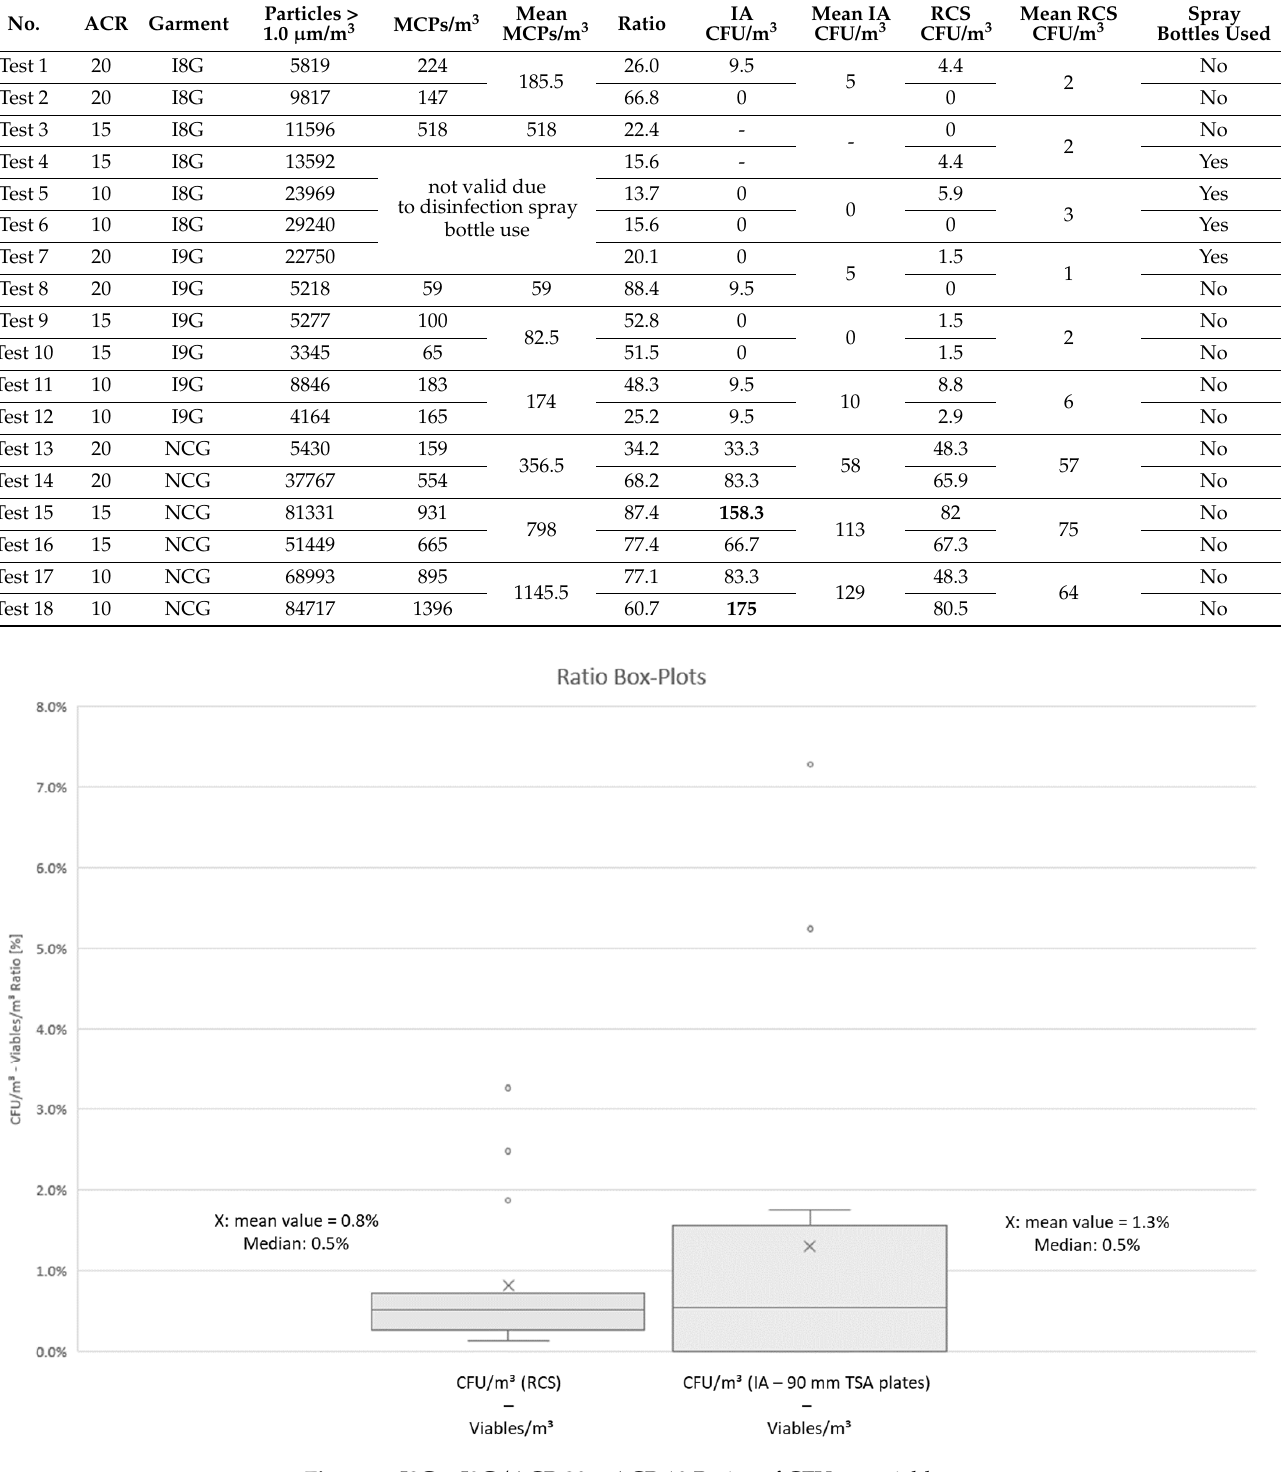
Table 3. ‘In Operation’ results.